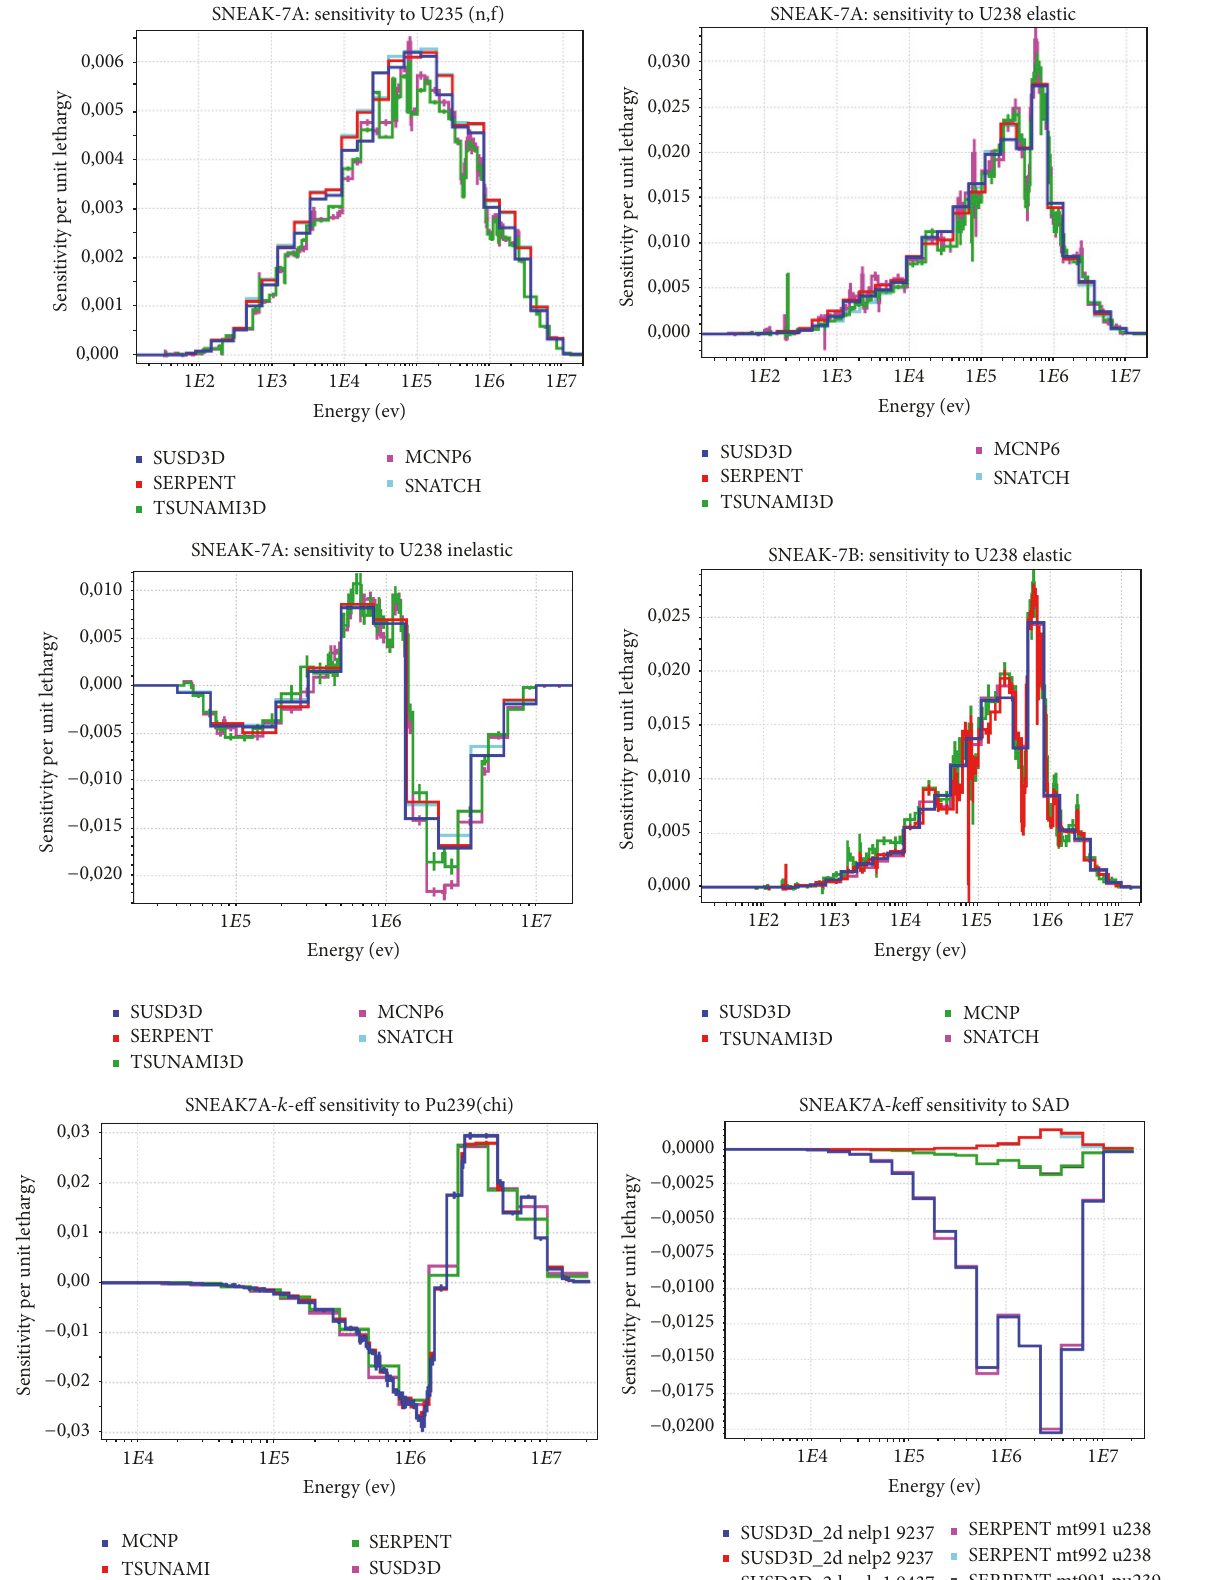
Figure 7: Example of sensitivities of 𝑘 eff to 235,238 U, 239 Pu cross-sections, prompt fission spectra (chi), and P 1 to P 3 elastic scattering angular distributions (SAD) calculated by the SUSD3D, SERPENT, TSUNAMI3D, MCNP6, and SNATCH codes, including numerically demanding elastic and inelastic data